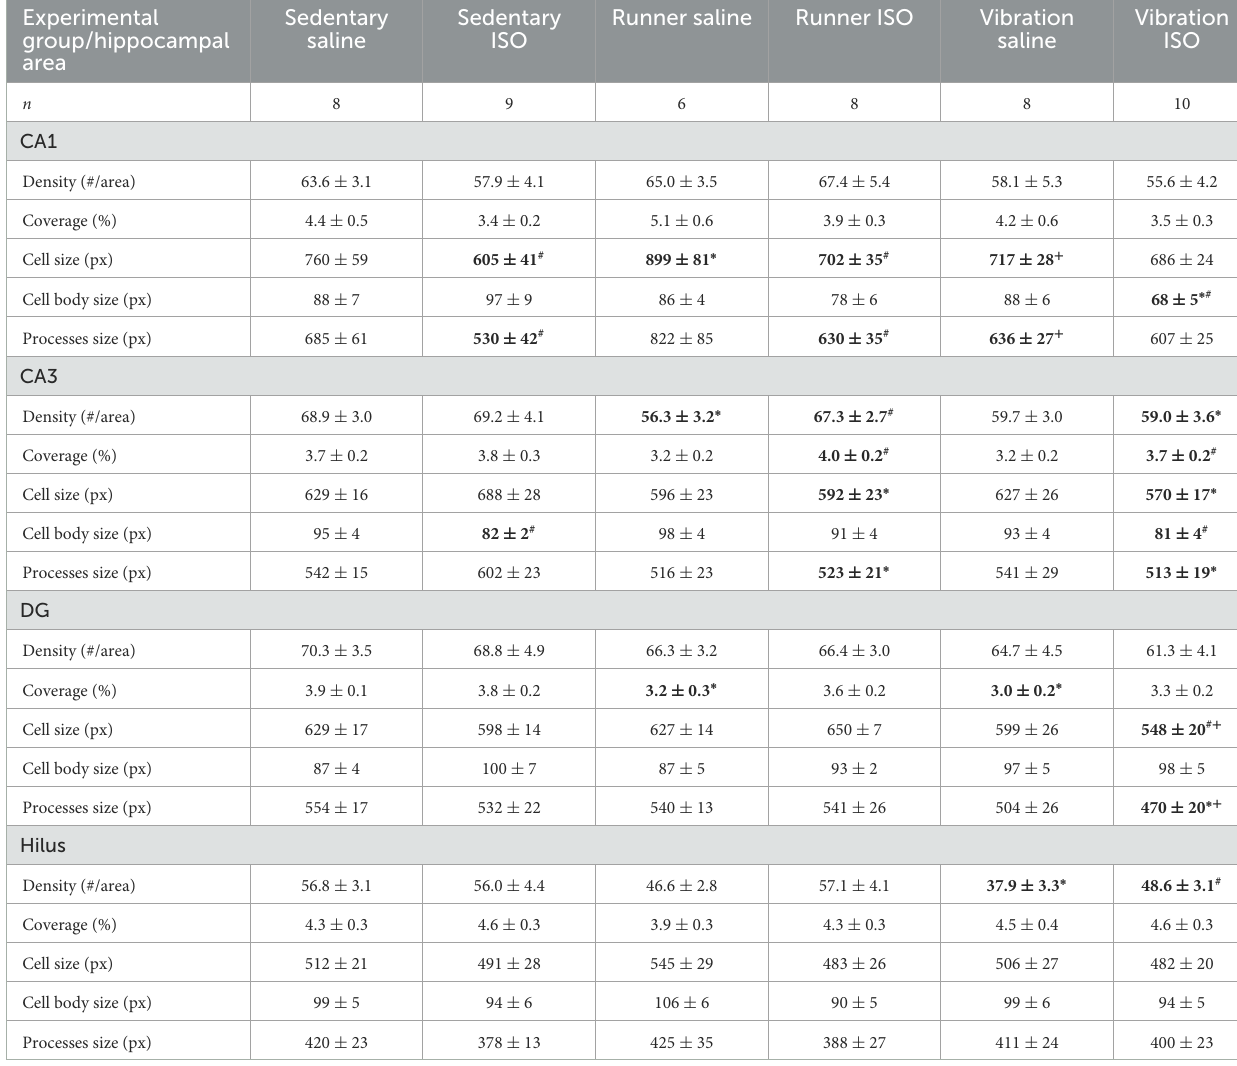
TABLE 2 Morphological parameters of microglia obtained in different hippocampal areas: CA1, CA3, dentate gyrus (DG), and hilus. Experimental